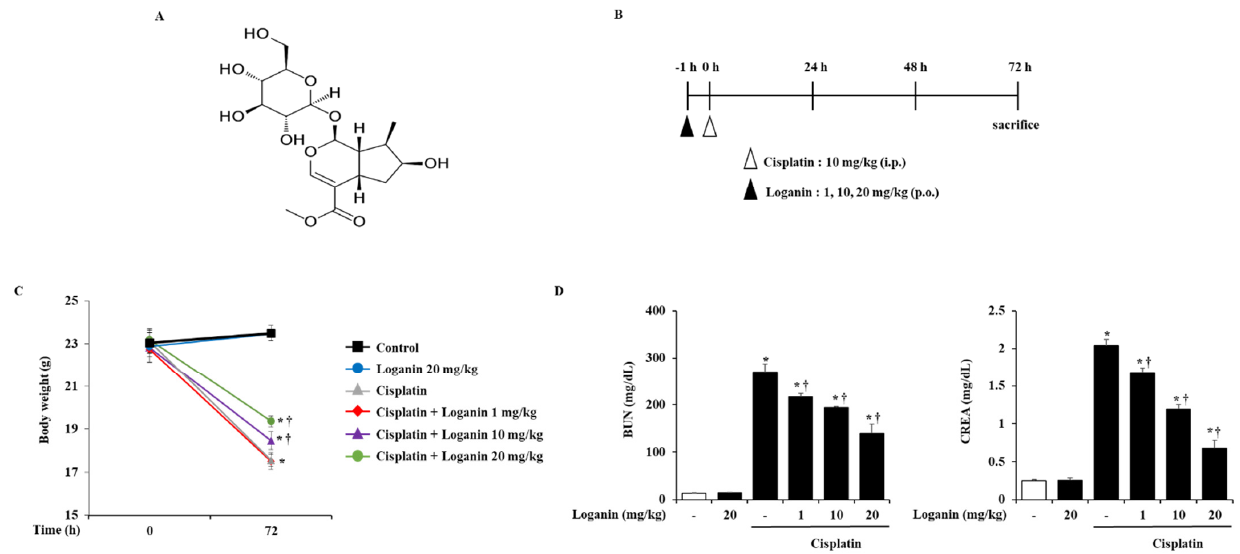
Figure 1. Effect of loganin on blood urea nitrogen (BUN) and creatinine (CREA) in cisplatin-induced acute kidney injury (AKI). ( A ) Molecular structure of loganin. ( B ) Mice pretreated with loganin (1, 10, or 20 mg/kg) were administered with intraperitoneal injections of cisplatin (10 mg/kg). They were killed at 72 h after the cisplatin injection. ( C ) Body weight changes, ( D ) serum BUN and CREA were measured at 72 h after cisplatin injection. Each experiment was repeated 3 times. Data are represented as mean ± SEM ( n = 9). An * indicates p < 0.05 vs. saline-treated control group; † indicates p < 0.05 vs. cisplatin treatment alone.